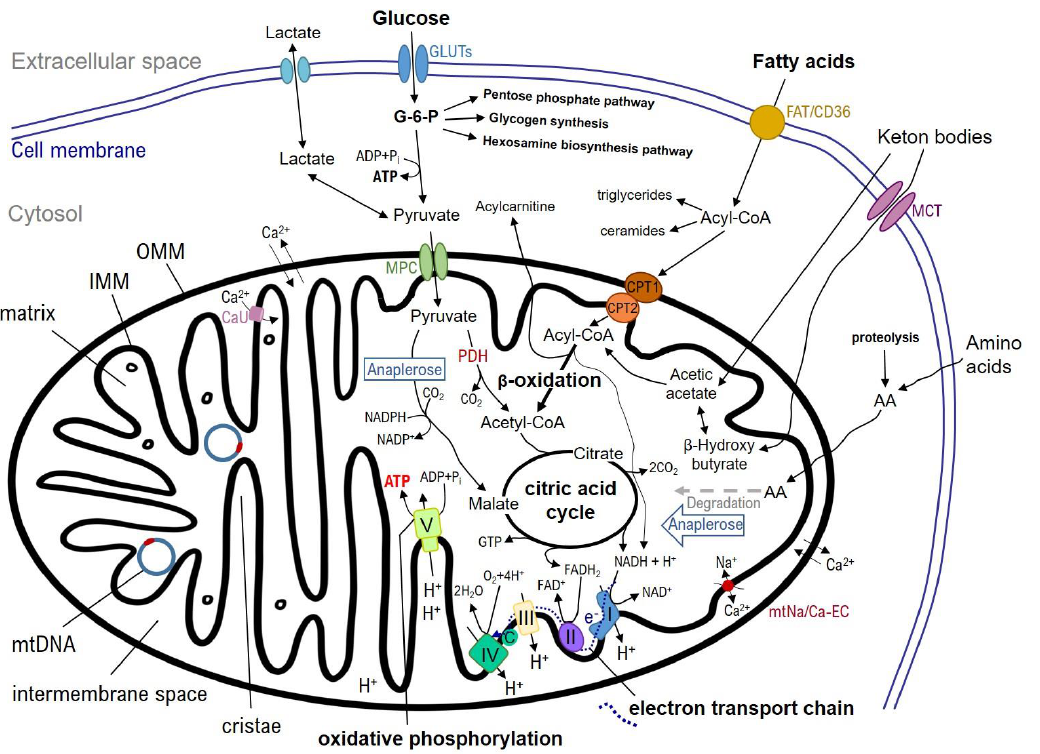
Figure 1. Schematic representation of the main metabolic pathways in mitochondria. The most important functions of the mitochondria include the citrate cycle, the β − oxidation of fatty acids and the mitochondrial respiratory chain with electron transport chain and oxidative phosphorylation. AA: amino acids, Acyl − CoA: acyl − coenzyme A, ADP: adenosine diphosphate, ATP: adenosine